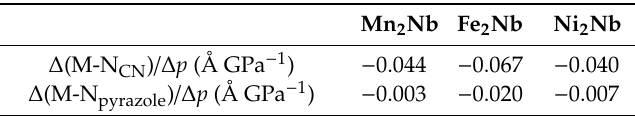
Table 2. Shrinkage of the M–N CN and M–N pyrazole bonds under pressure. The ∆ (M–N) / ∆ p values are the slopes of the best linear fit from Figure